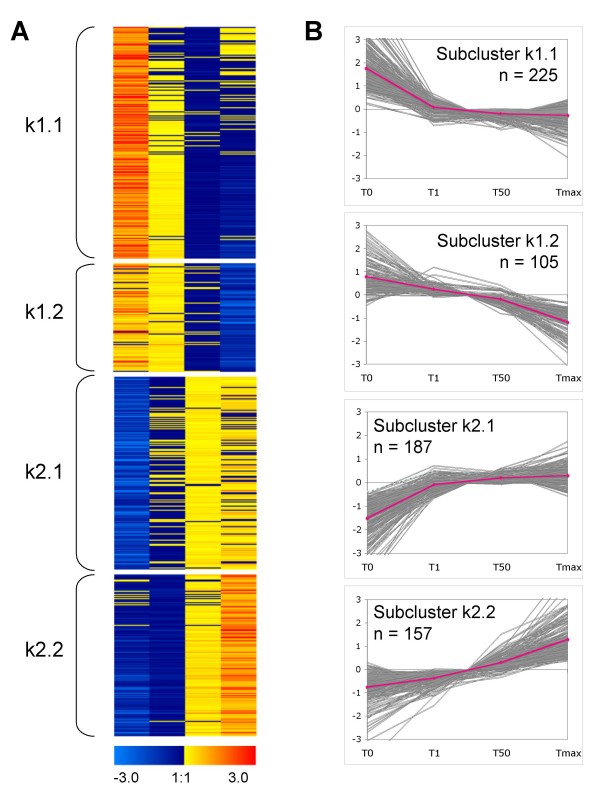
K-mean clustering of 674 genes expressed differentially during germination under standard conditions. Gene expression was monitored in dry (T0) and germinating (T1, T50, Tmax) seeds. Transcript abundance is shown as Log2-transform and gene-centered signal intensities. (A) Every horizontal row represents an individual gene. Red indicates transcript abundance above the mean and blue indicates transcript abundance below the mean (see also colour scale at bottom). (B) Temporal alterations of transcript abundance are shown. Transcript profile of each gene is shown as a grey line, magenta lines indicate the averaged expression values for each cluster.